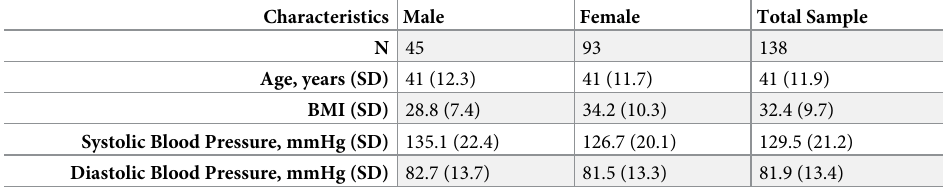
Table 1. Mean characteristics of study